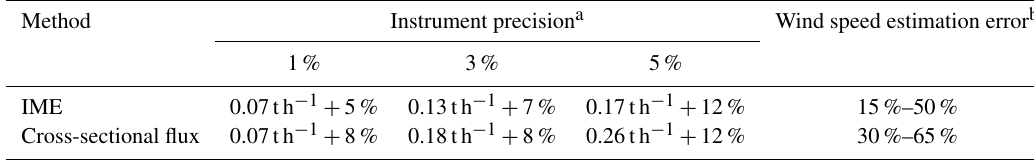
Table 1. Error standard deviations for retrieving point source rates from column plume observations.